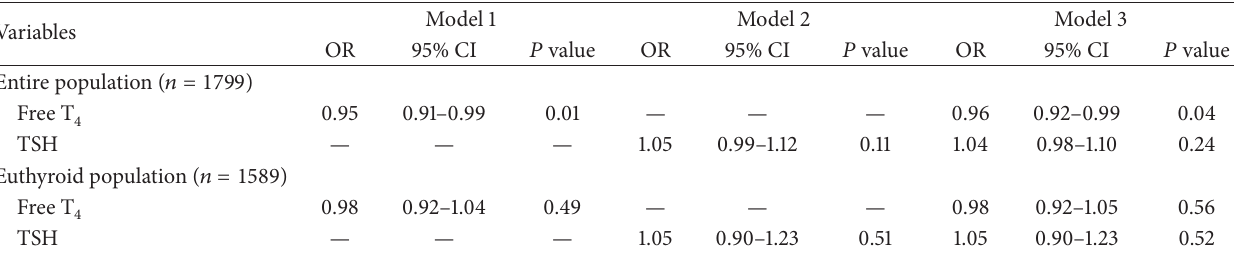
Table 3: Odds ratio of prevalent coronary heart disease by free T 4 and TSH.